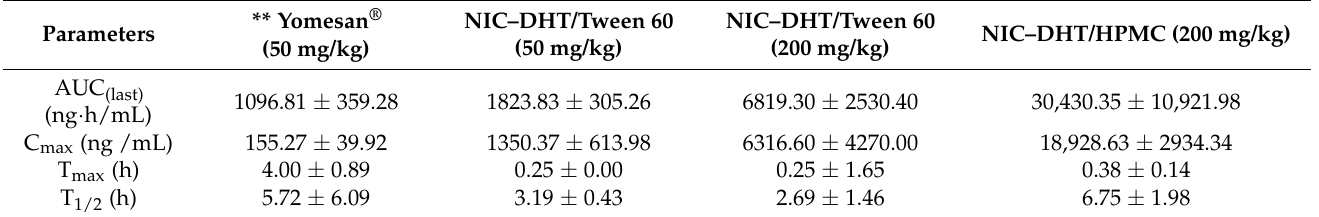
Table 2. PK parameters of NIC after a single oral administration of Yomesan ® , NIC–DHT/Tween 60 and NIC–DHT/HPMC nanohybrid formulations in rats (** only the Yomesan ® data shown here were reused from Reference [51] (This data shown here is reused under Creative Commons Attribution (CC BY) license (http://creativecommons.org/licenses/by/4.0/), which was our previous study related to NIC-MMT nanohybrids) ( n =